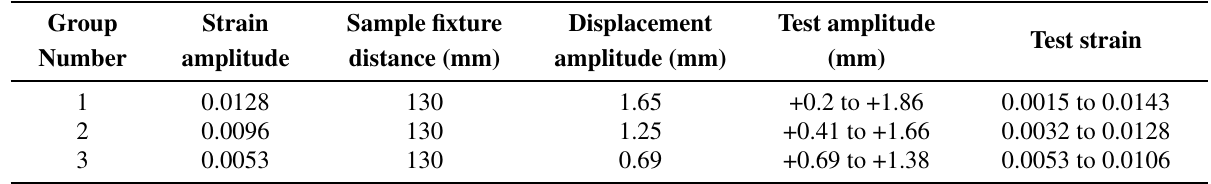
Table 2. HDPE fatigue testing conditions.